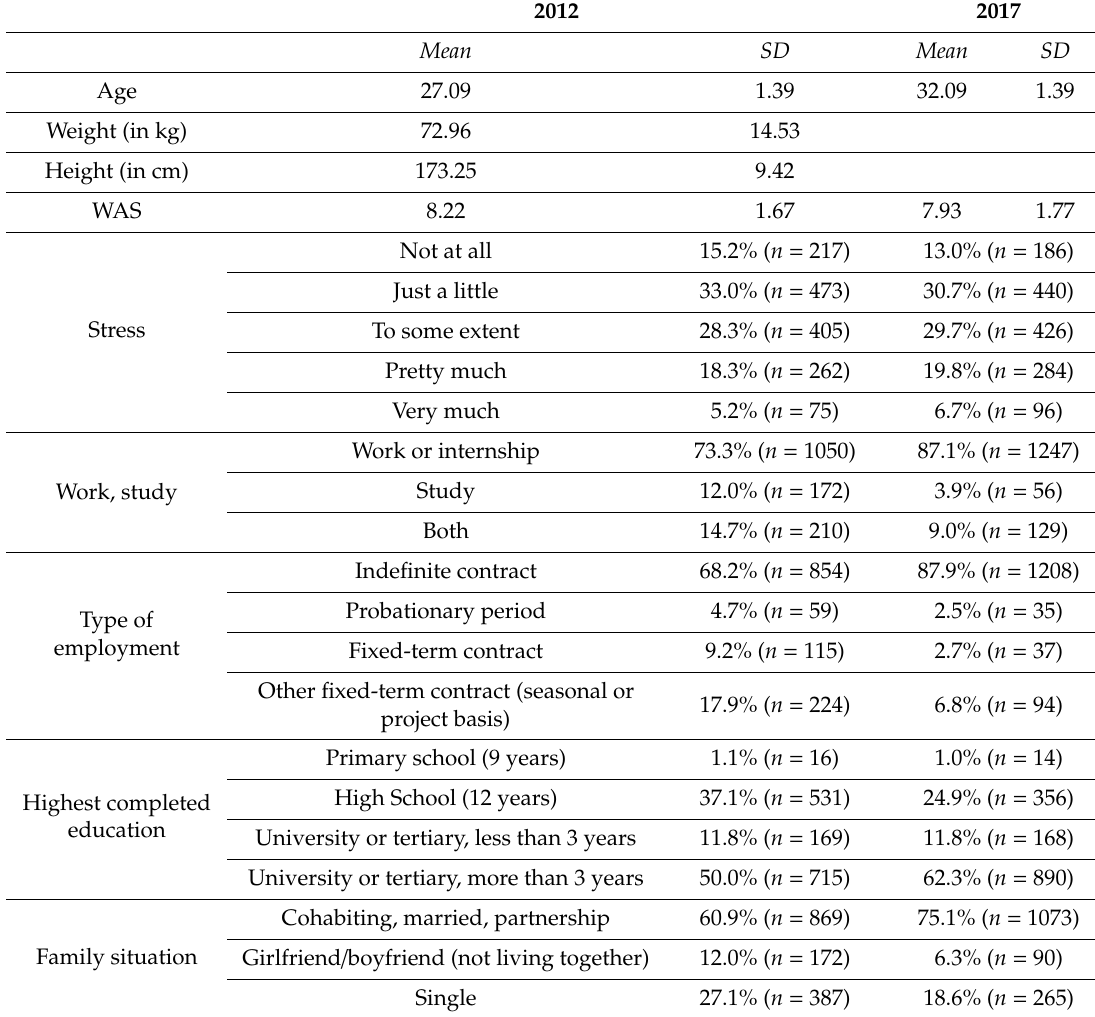
Table 1. Demographic variables mean and standard deviation (SD) of the study population that answered the questions on stress and work ability in 2012 and 2017 ( N = 1432).